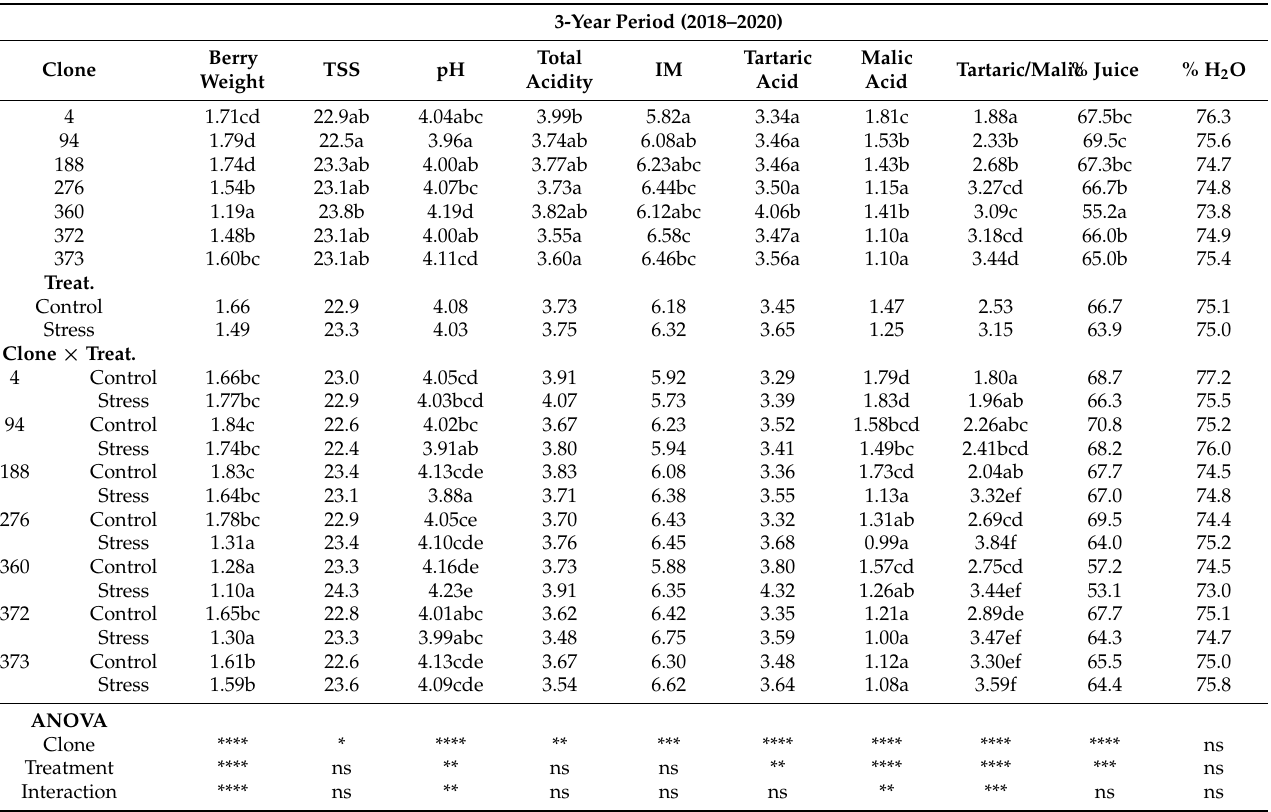
Table 6. Average annual values of berry technological quality at harvest for each clone, irrigation treatment, and the interaction (clones × irrigation treatment) during the 3-year period 2018–2020.